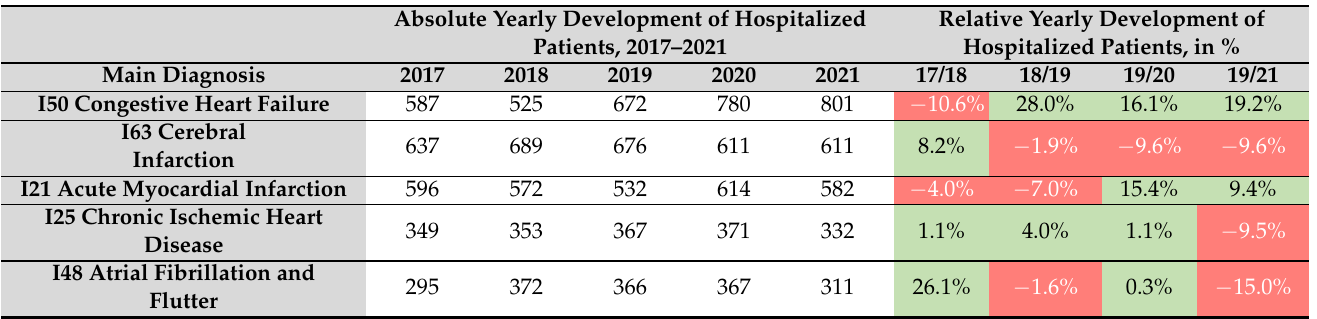
Table 4. Absolute and relative development of yearly hospitalized patients of the most common main cardiovascular main diagnoses,